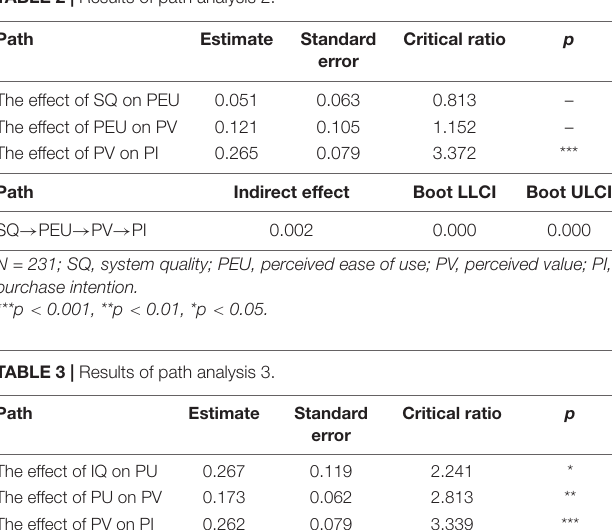
TABLE 2 | Results of path analysis 2.